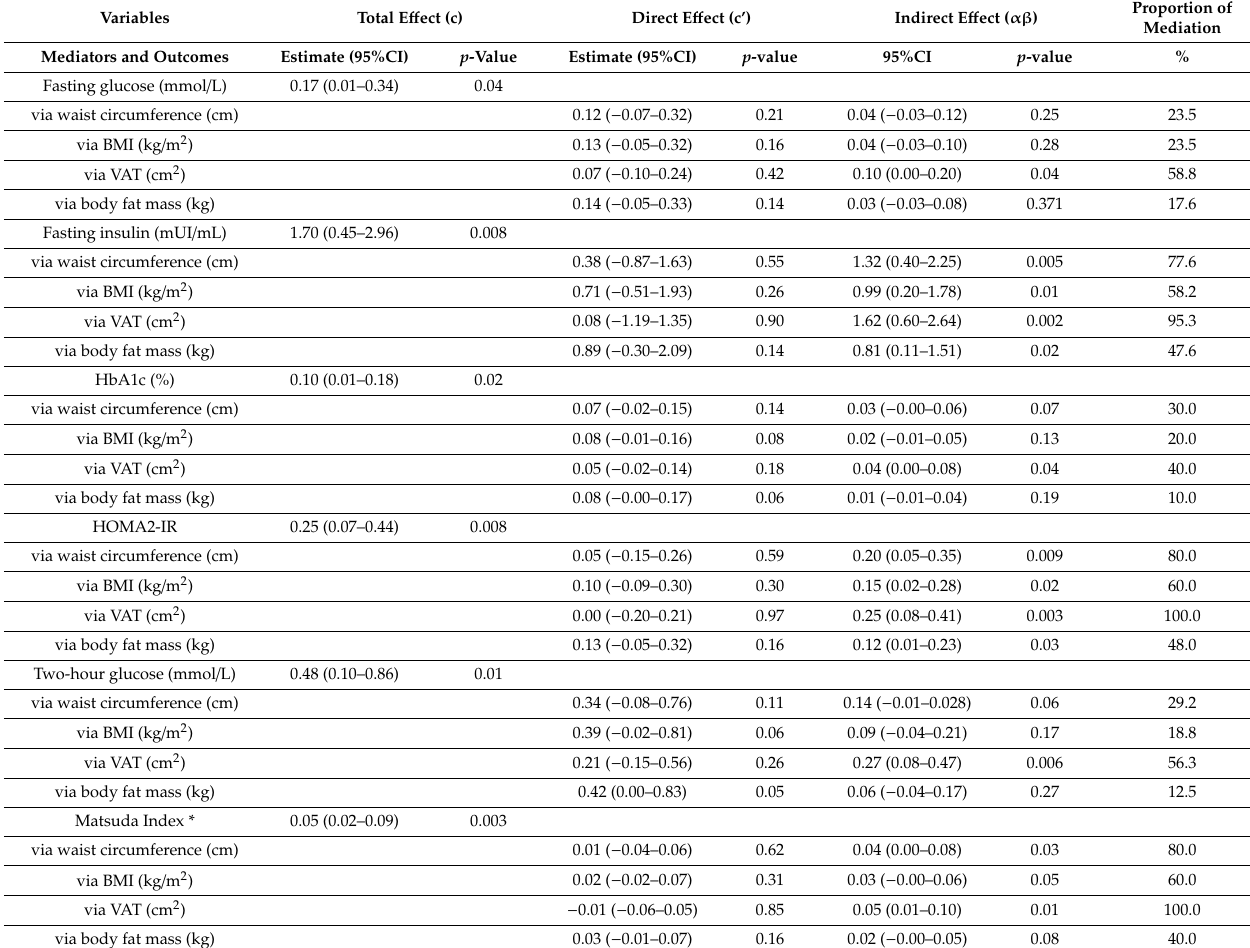
Table 2. Direct and indirect e ff ects of E-DII on markers of T2D risk with body composition as mediators in black South African (SA) women.